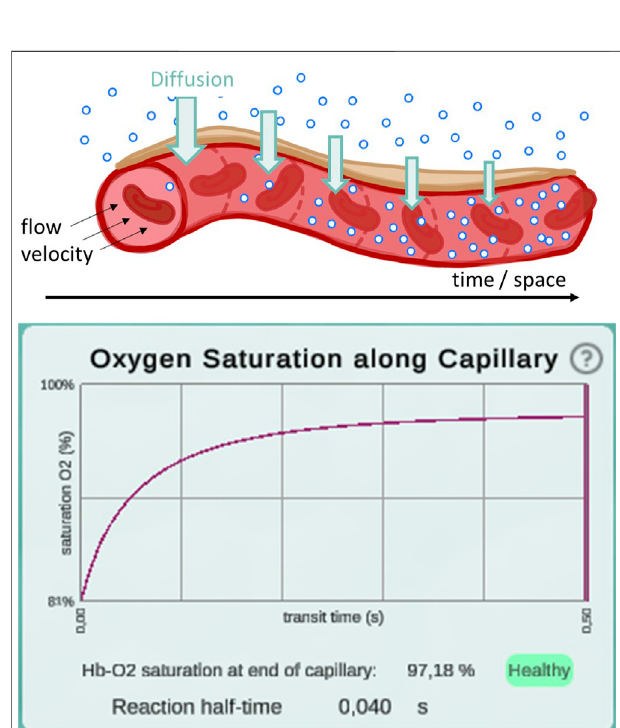
FIGURE 3 | Illustration of the diffusion gradient along the model capillary (top) and a screenshot of the plot displaying oxygen saturation along capillary between 81 and 97% (bottom). This screenshot was taken from a simulation with pO 2 values of 97 mmHg in the alveolar space and 46 mmHg in the deoxygenated blood. All other parameters remained at their default settings. Reaction half-time is de fi ned as the time point at which 50% of the oxygenation that blood undergoes during its transit along the alveolus is